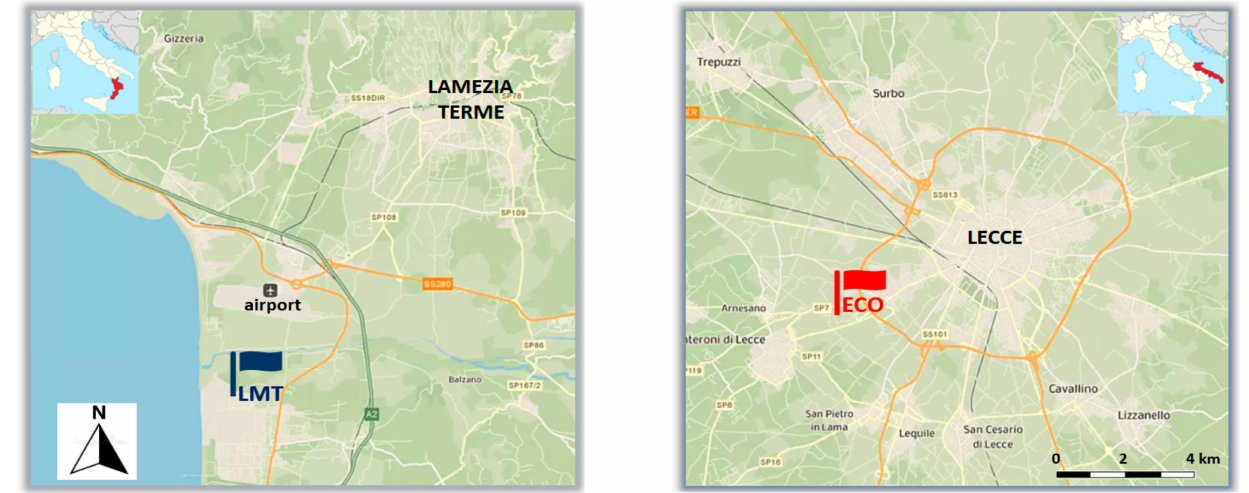
Figure 1. Position of the two environmental observatories analyzed in this work: Lamezia Terme (LMT) and Lecce